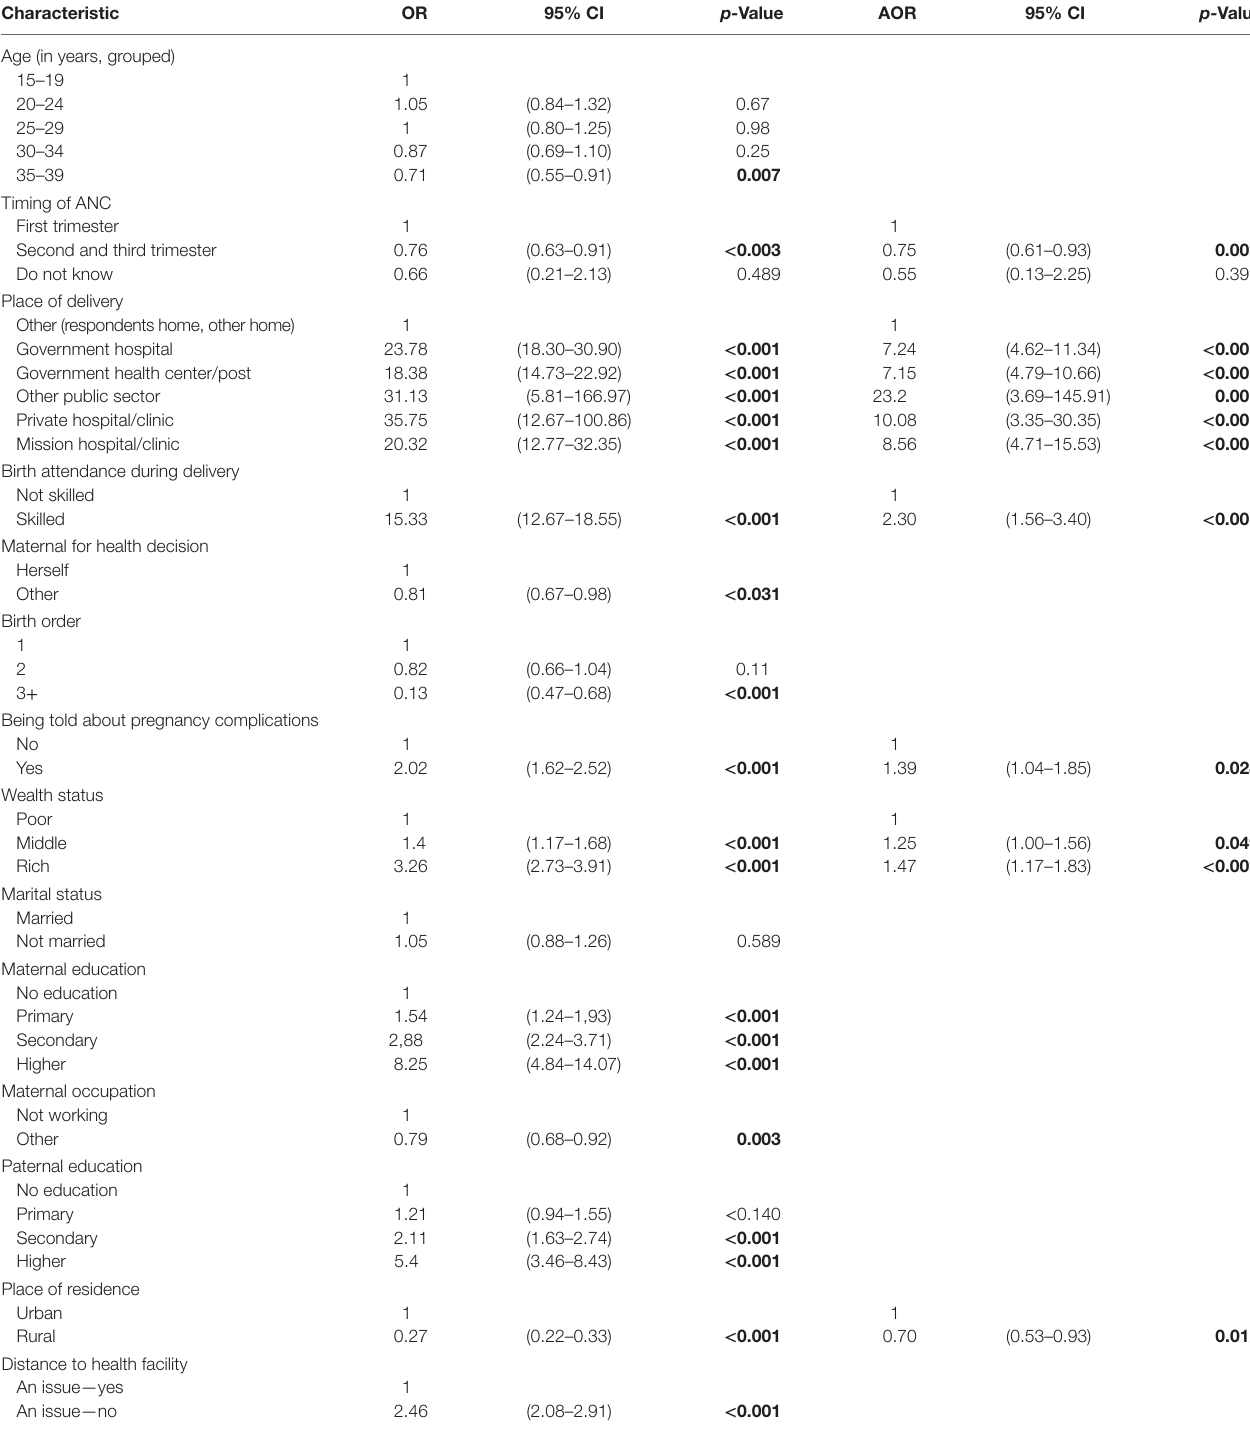
Table 3 | Key predictors of maternal postnatal care utilization in Zambia—Results of multivariate logistic regression.